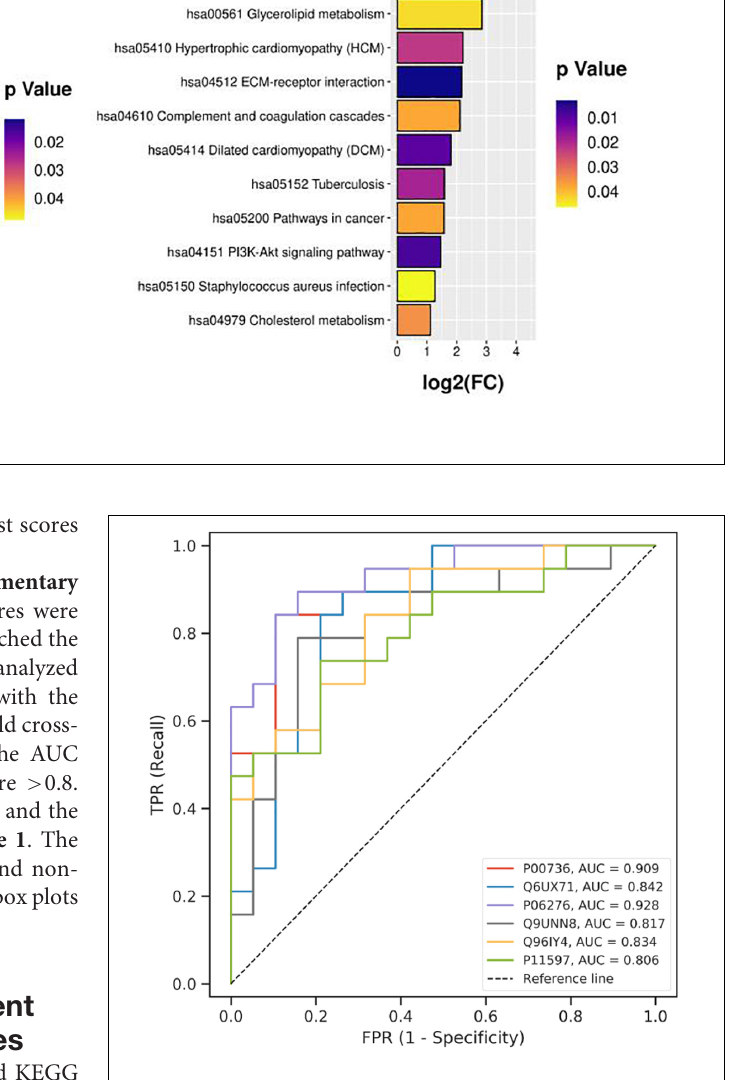
FIGURE 3 | ROC curve of the model using the candidate proteins in machine